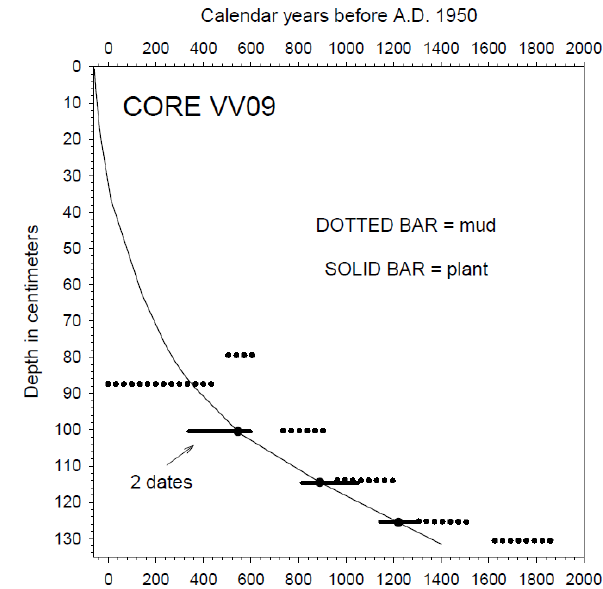
Fig. 4. Age-depth model for core VF7-IV. The 2-sigma calendar age ranges for AMS dates on plant remains (black bars) and bulk sediment (dotted). The uppermost 8cm were lost during collection.